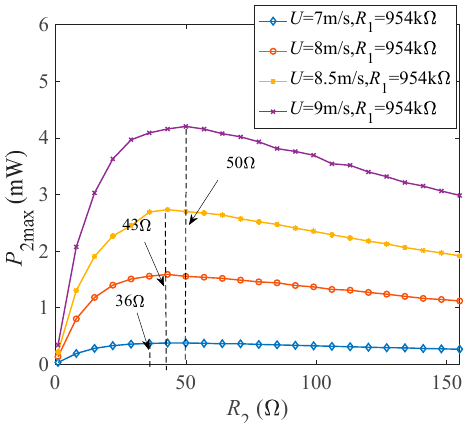
Figure 7. The curve of the output power P 2max with its load resistance R 2 ( 𝑈 = 7, 8, 8.5, 9 m/s)